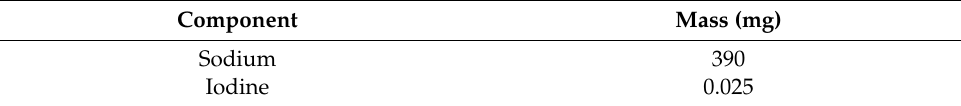
Table 3. Nutritional information of salt (a portion of 1 g).